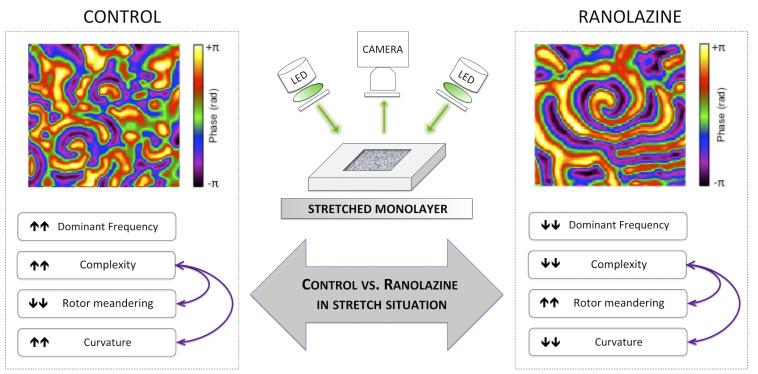
Summary of the main findings of the study: effects of the inhibition of late sodium current by ranolazine on activation patterns in stretched atrial cell monolayers.